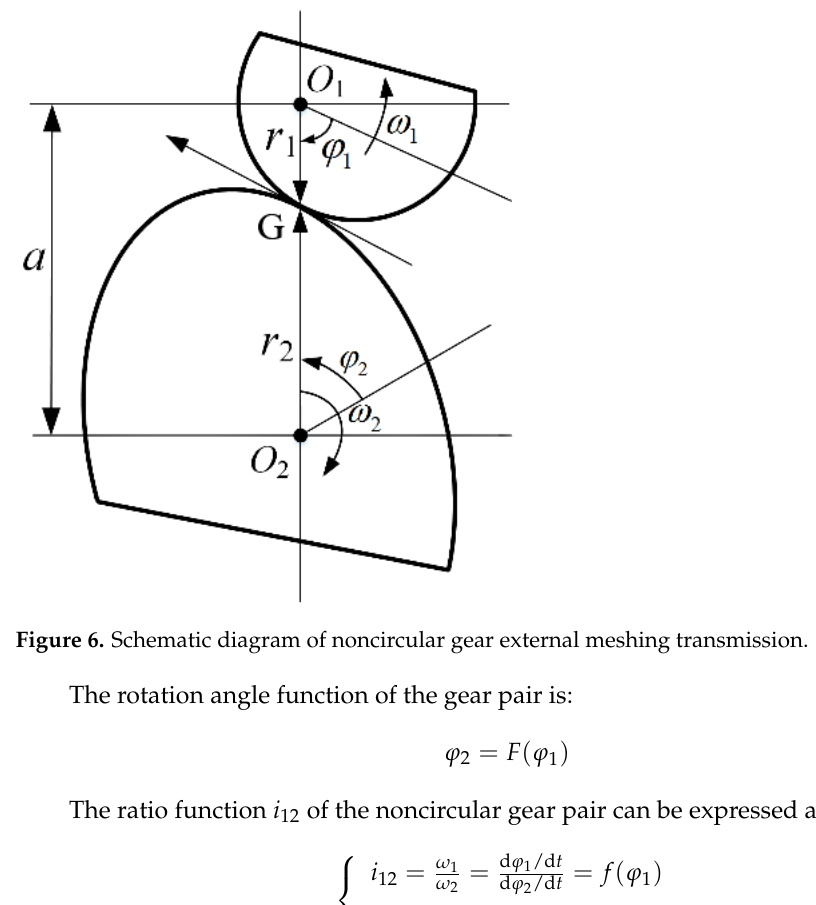
Figure 6 is a schematic diagram of the noncircular gear external meshing transmission. The center distance of the noncircular gear pair is a . The rotation center of driving gear is O 1 , the rotation angle is ϕ 1 and the angular velocity is ω 1 . The rotation center of the driven gear is O 2 , the rotation angle is ϕ 2 and the angular velocity is ω 2 .